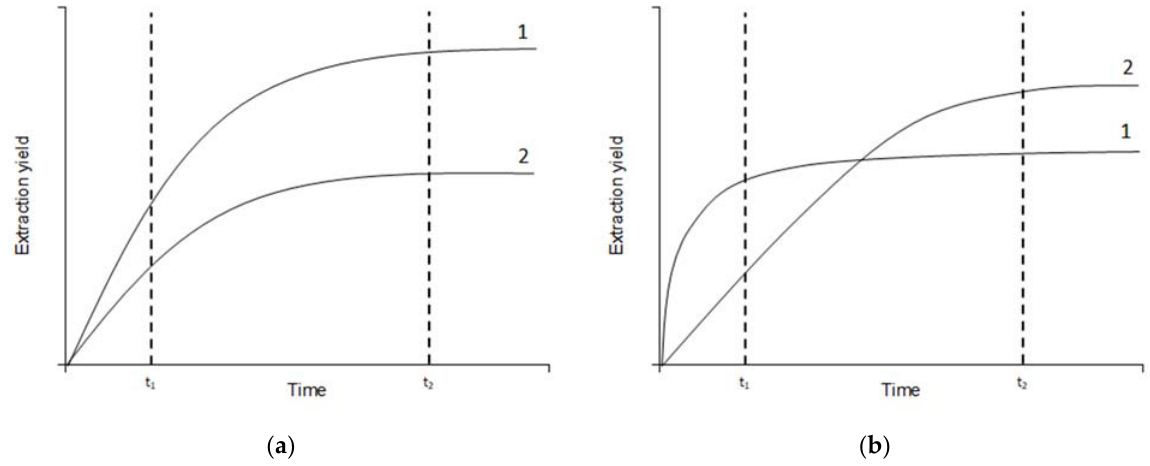
Figure 1. Theoretically possible mutual arrangements of kinetic curves of two solvents. ( a ) Curves do not cross, ( b ) curves do cross. Table 1. Box–Behnken design of experiment